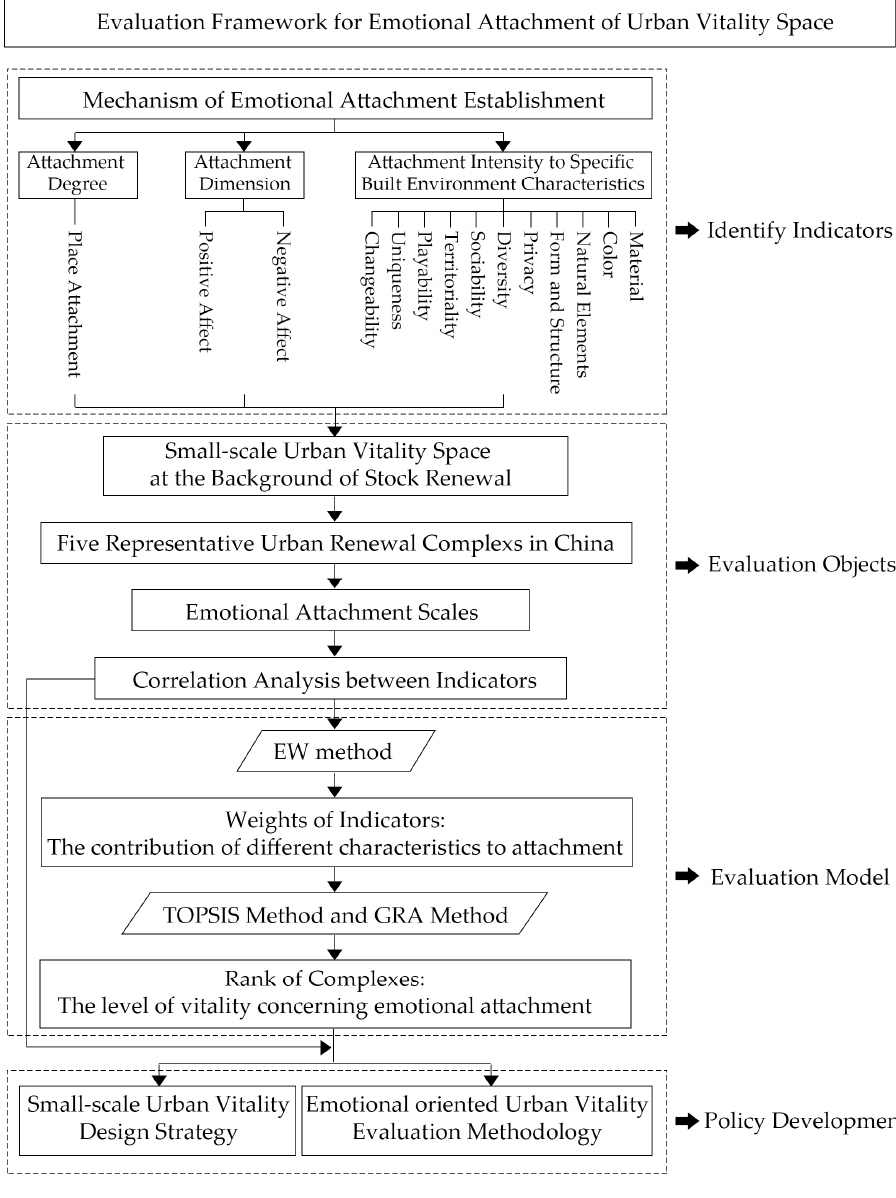
Figure 2. Flowchart of the proposed